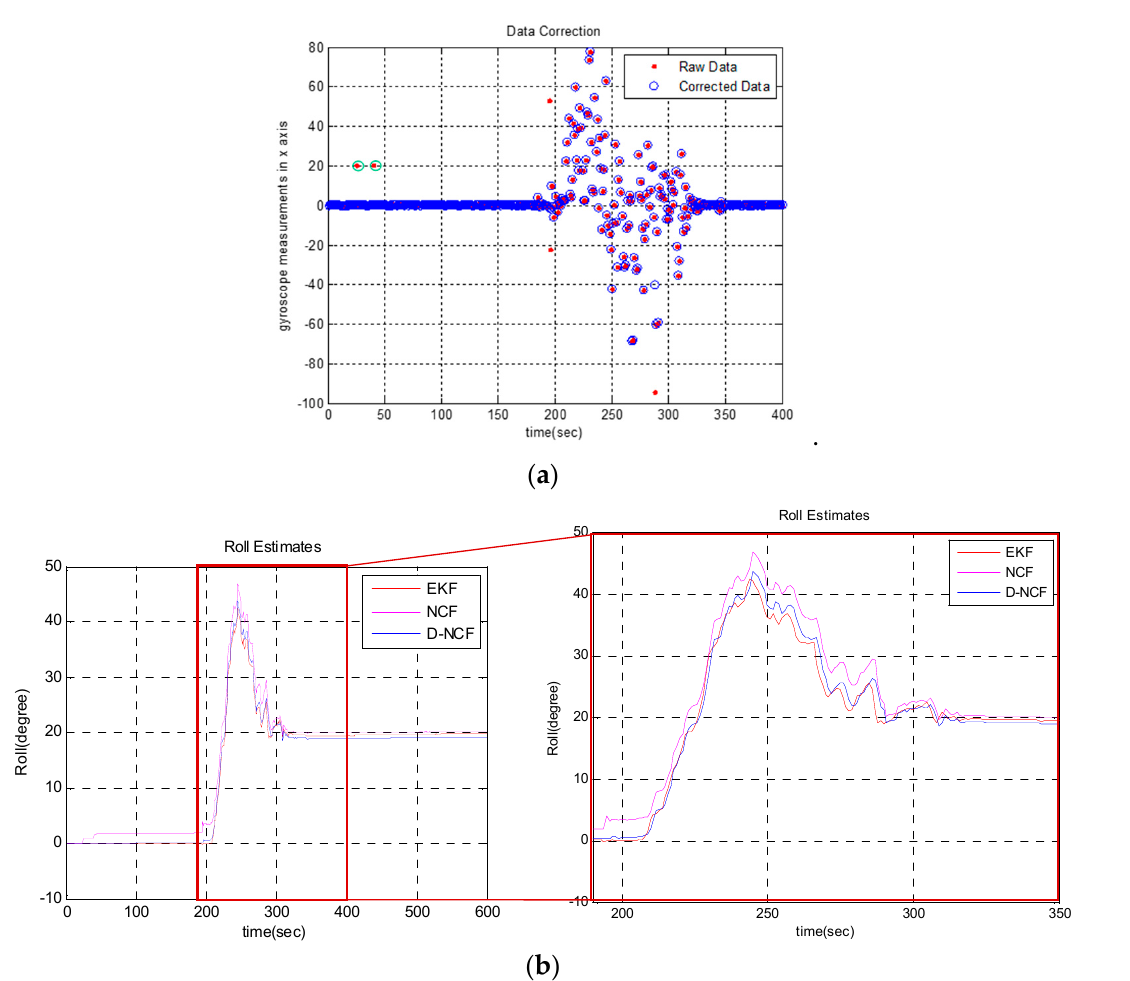
Figure 6. Examine result of robustness of D-NCF algorithm: ( a ) Processing result of the error data by using first-order differential data processing algorithm; ( b ) estimated result of roll angle after adding the error data.